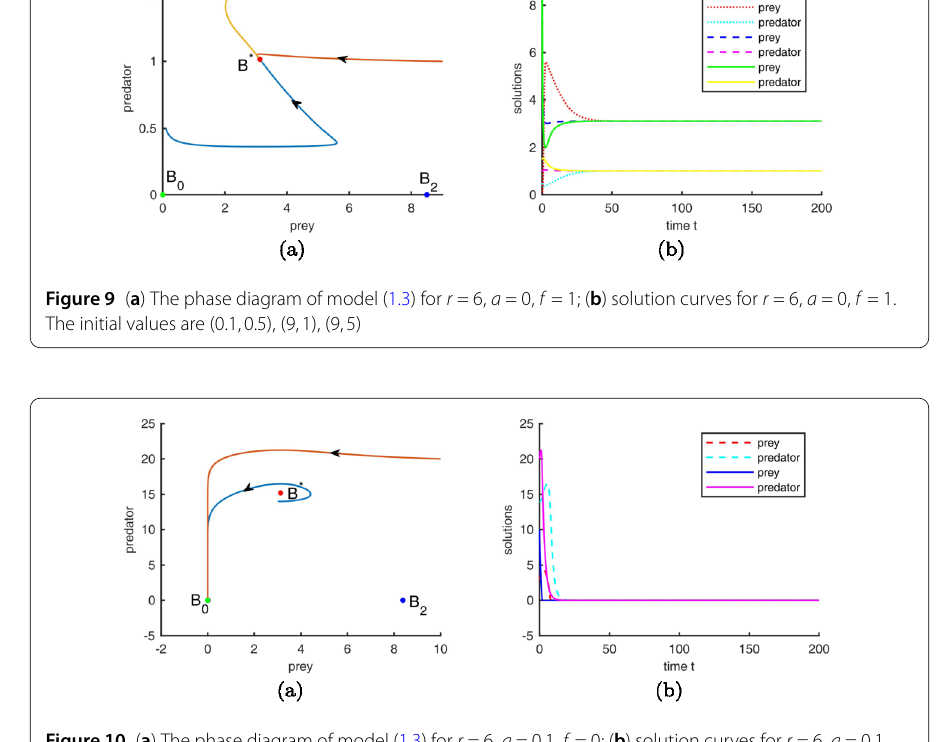
predators y ∗ , but also changes B ∗ from stable to unstable. The simulation results are shown in Fig.